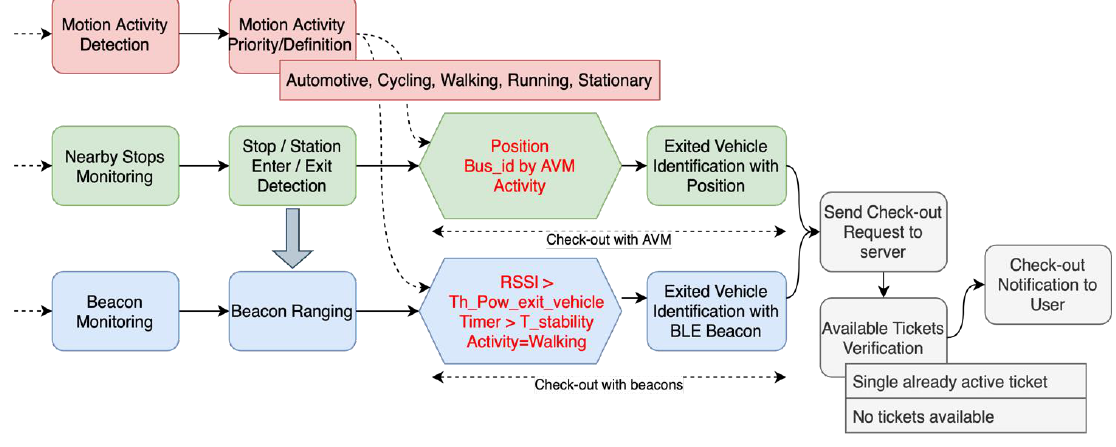
Figure 6. Flow diagram — check-out operations.